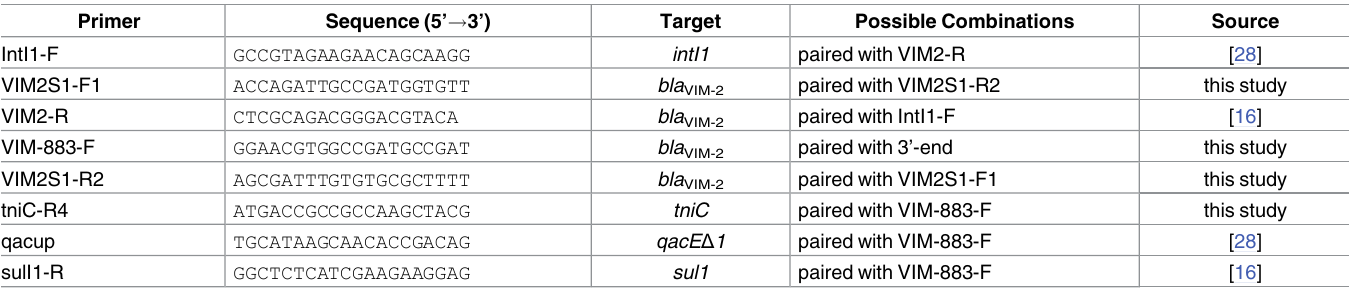
Table 1. Primers used in this study for PCR and